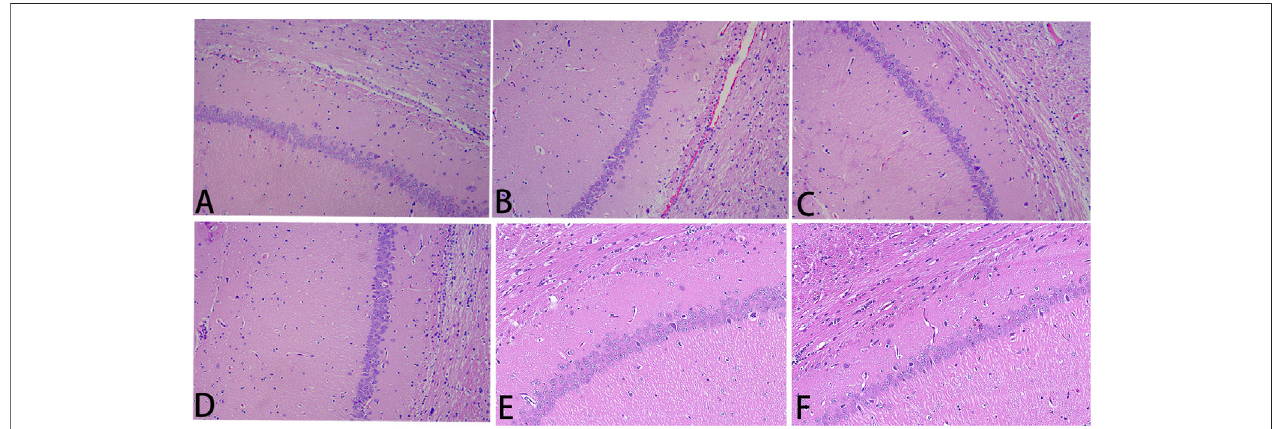
FIGURE 6 | Elisa analysis of NLXTD. Notes: ## p < 0.05 vs. Sham group; ** p < 0.05 vs. I/R group.